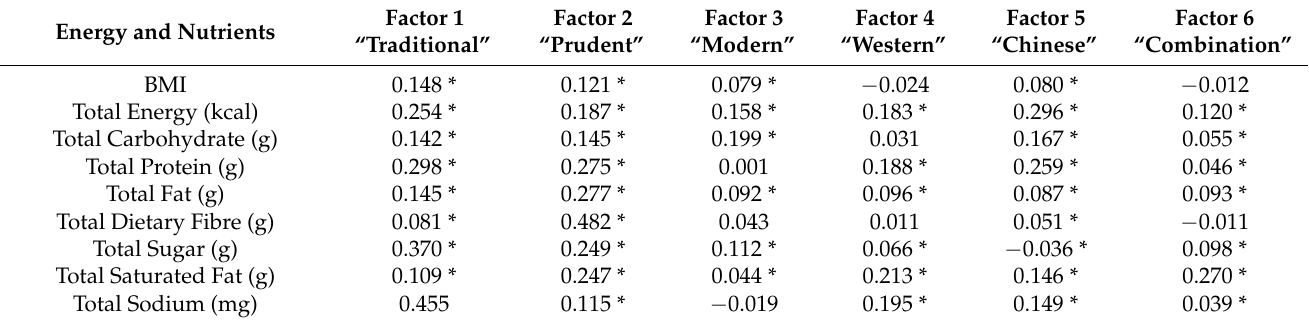
Table 7. Correlation coefficients among six food patterns and total energy intake, nutrient intake and BMI of respondents. Energy and